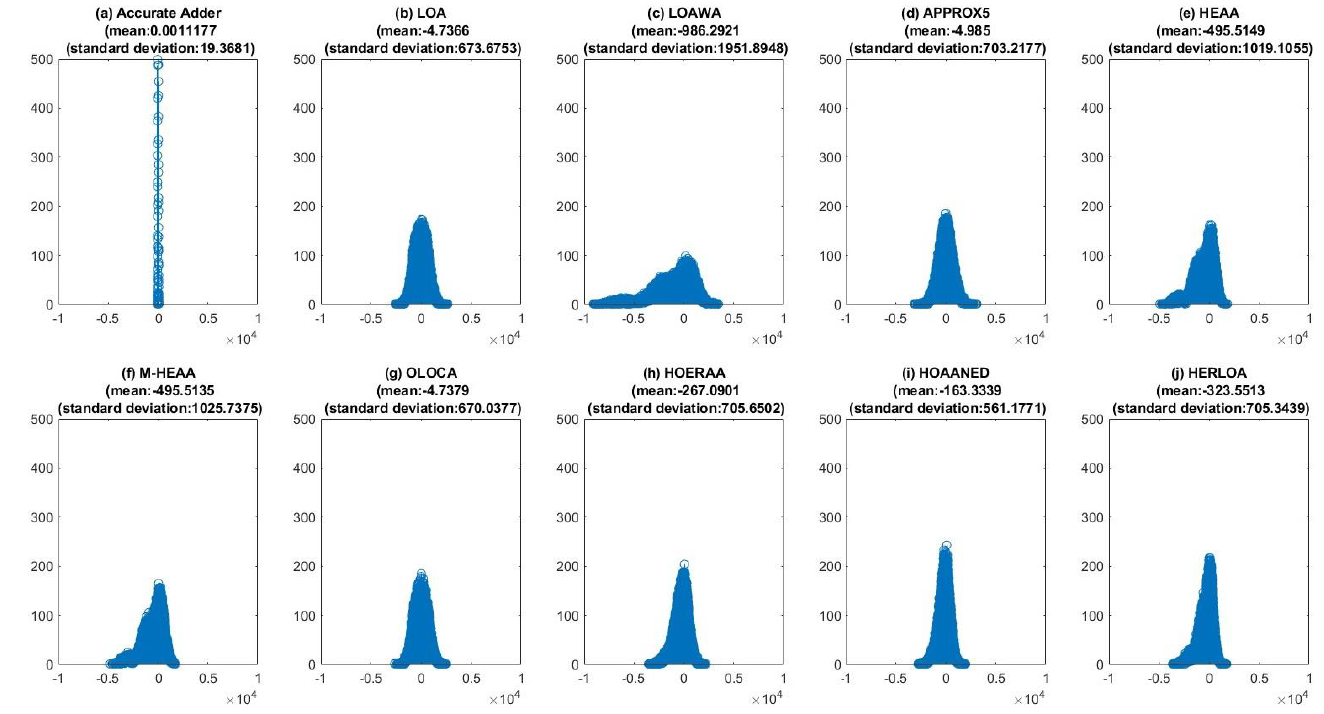
Figure 7. Plots showing the DPV between the La Silla image compressed using accurate and ap- proximate adders and the original La Silla image, with the approximate adders having an 11-bit inexact part.